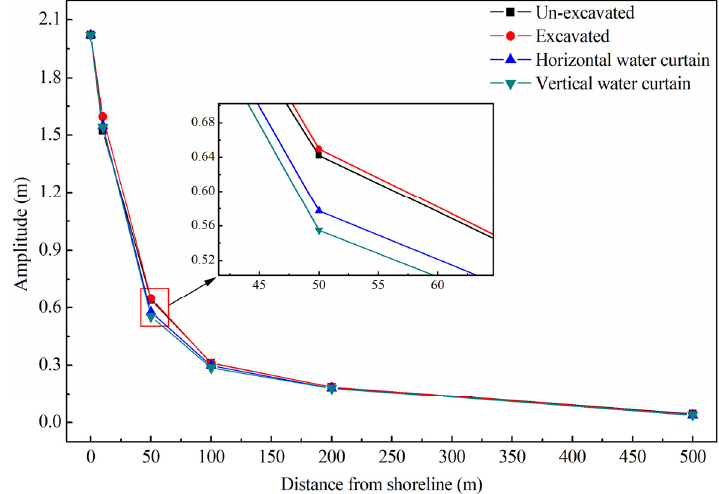
Figure 13. Tidal water table fluctuation amplitude damping.